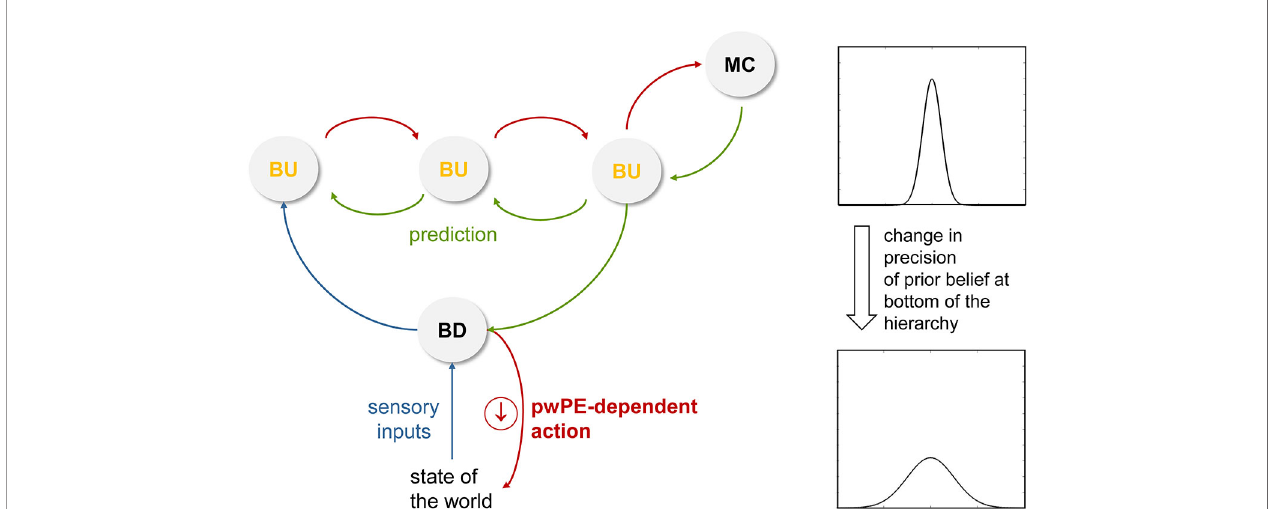
FIGURE 8 | This fi gure illustrates a hypothetical mechanism for the reduction of reactivity. Here, a reduced precision of beliefs about the state of the world (e.g., bodily states) decreases the tendency to react to any discrepancy between the sensory inputs expected under this belief and the actual sensory inputs (prediction error). This is because the vigor of re fl ex-like actions that are emitted to “ defend ” beliefs depends on precision-weighted prediction error (see Stephan et al. (85) for mathematical details). pwPE, precision-weighted prediction errors; BU, belief updates; BD, belief defending. Compare Figure 4 for a (hypothetical) anatomical circuit and see main text for